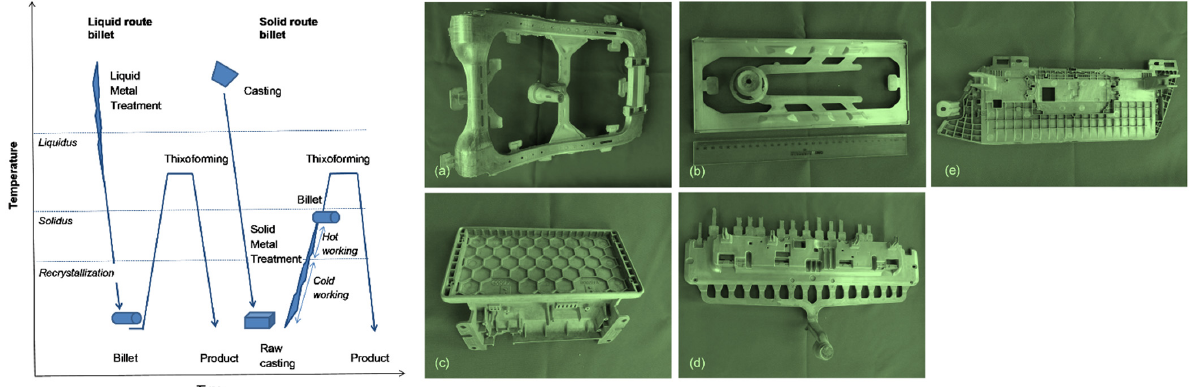
Figure 14. Schematics of semisolid processing and examples of automotive components manufactured from magnesium alloy using injection molding: ( a ) car seat backrest AM50, 1970 g; ( b ) car dashboard member AZ91D, 138 g; ( c ) car navigator member AZ91D, 280 g; ( d ) car dashboard member AZ91D, 710 g; and ( e ) car navigator member AZ91D, 278 g. Parts manufactured by SSD Magnesium, China [76].